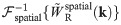
Cortical feedback modulates the center-surround receptive fields of relay cells.Upper left: the two dimensional spatial structure of the impulse-response function. Bottom left: one-dimensional plot of the impulse-response function. Center excitation and surround inhibition correspond to the maximum and minimum value of Fspatial-1{W˜Rspatial(k)}(r), respectively, while where the zero-crossing occurs is used as an indication for the receptive field size. Right: spatial impulse-response function for different circuit configurations. In each case all other contributions are removed, except feedforward excitation. Default parameters from Table 1 have been used.